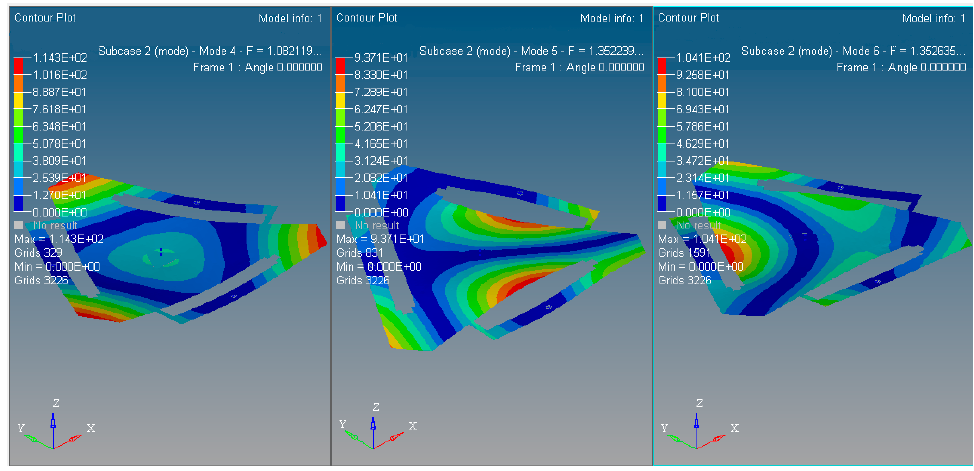
Figure 16. The 4th~6th order modal shapes of the multi-objective optimized with the new mechanism.